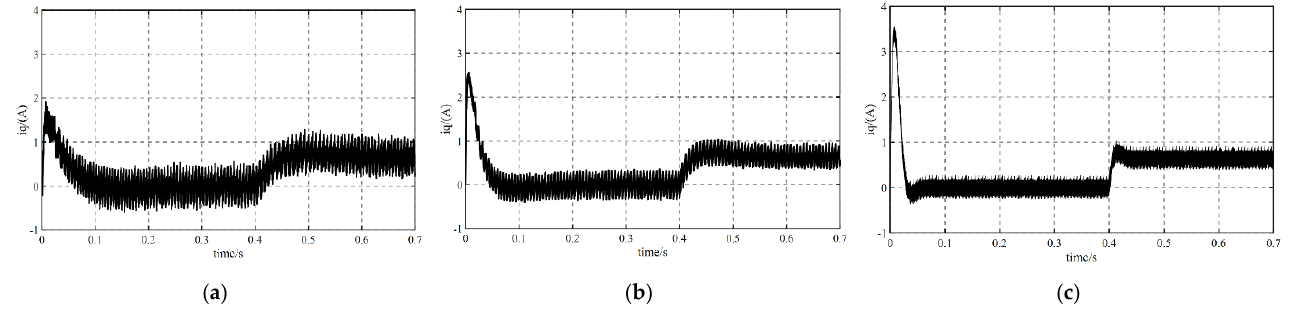
Figure 19. Comparison of the current waveforms of the 3 systems under a sudden load: ( a ) PI system; ( b ) SMC system; and ( c ) MPC system.